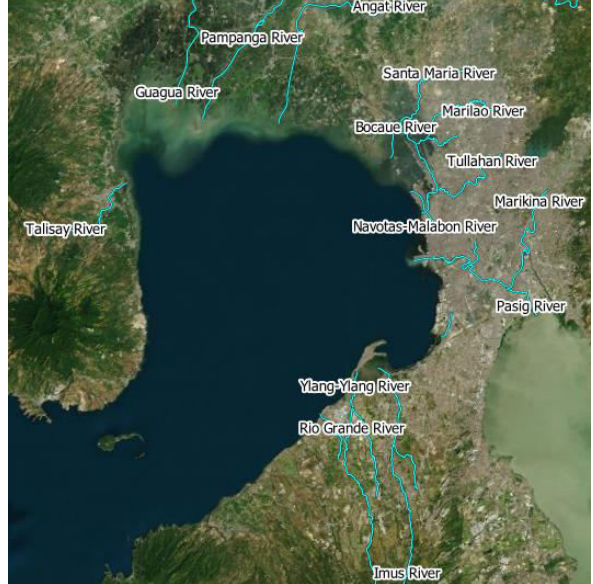
Figure 1. Major rivers of Manila Bay depicted as blue